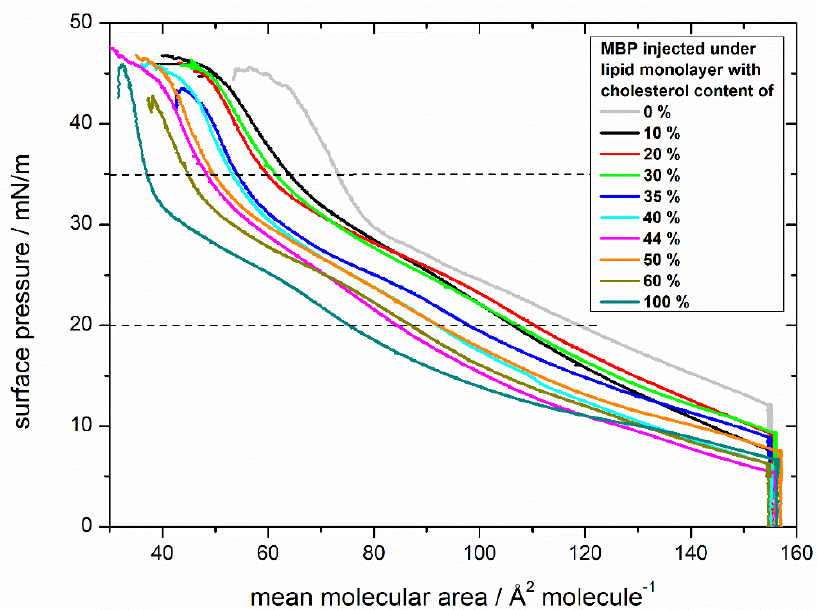
Figure 2. Comparison of compression isotherms of lipid monolayers with differing cholesterol contents and myelin basic protein (MBP). Monolayers have a composition similar to the cytoplasmic leaflet of the myelin sheath with varying amount of cholesterol (0%, 10%, 20%, 30%, 35%, 40%, 44%, 50%, 60%, 100%) on a HEPES-NaCl subphase. Myelin basic protein was injected into the subphase (100 nM). The dashed lines at 20 and 35 mN/m divide the isotherms in the three discussed regions and visualize the area values taken for further analysis (Figure 3).